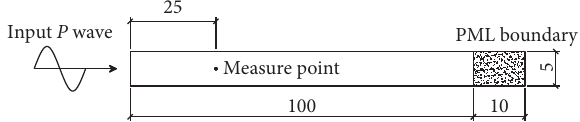
Figure 19: Test model of the